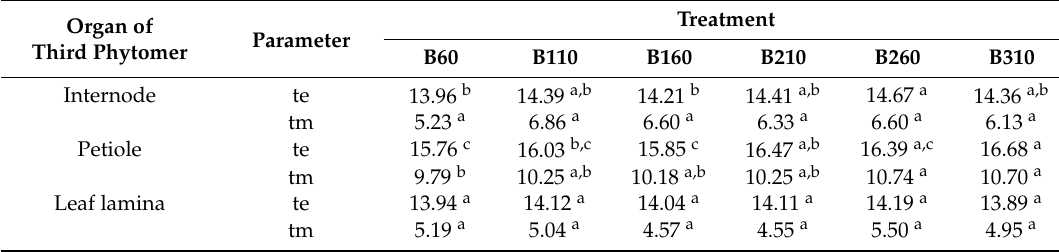
Table 4. Least square means of estimated parameters of the beta-function. Time of elongation (te) and time of maximum elongation (tm) for internode, petiole and leaf at the third phytomer under di ff erent blue photosynthetic flux densities (BPFD). Letters indicate significant di ff erences between treatments ( p <